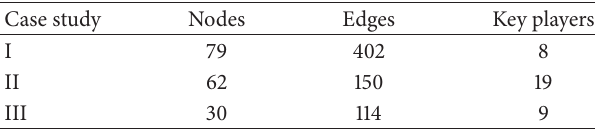
Table 6: Network